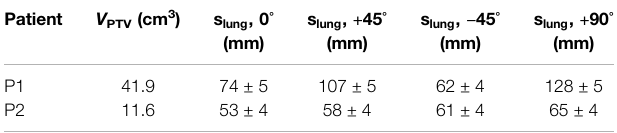
TABLE 1 | PTV volumes V PTV and estimated travel distances through the lung to the isocenter s lung for both patient cases.